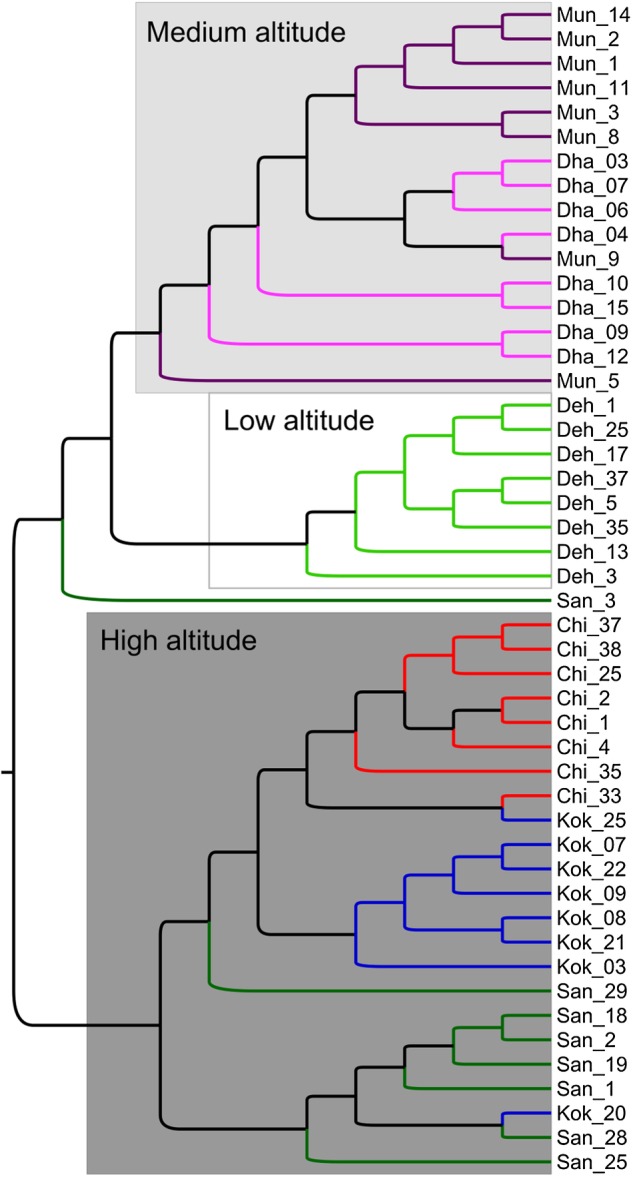
Majority rule consensus tree of 500 un-rooted NJ trees. Genetic distance matrix of 19 MS markers was used for construction of the tree. The three clades corresponding to the populations from the three altitudinal zones (low, medium and high) are shown as shades of grey. All the branches are 100 % supported.